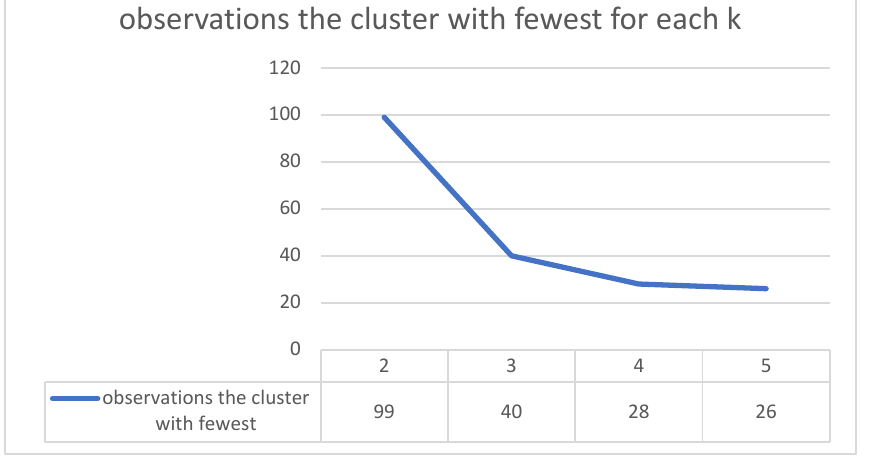
Figure 4. Clustering performance visualization. ( a ) Sum of squares within the plot showing how similar objects are in a cluster; ( b ) Silhouette score plot shows the quality of clusters.